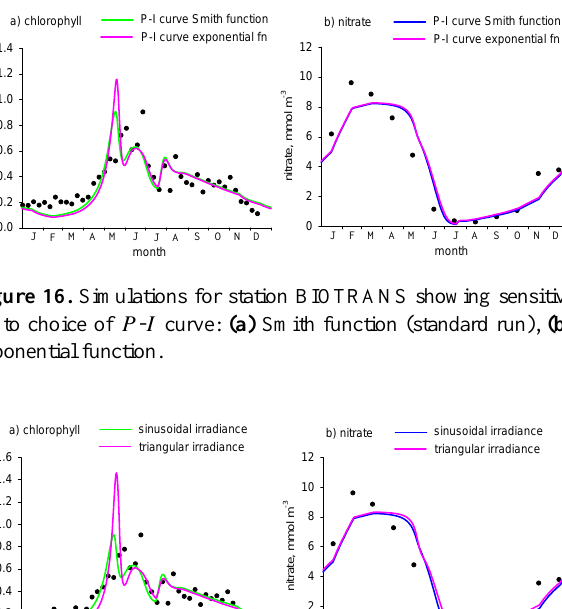
curve Smith function P-I curve exponential fn